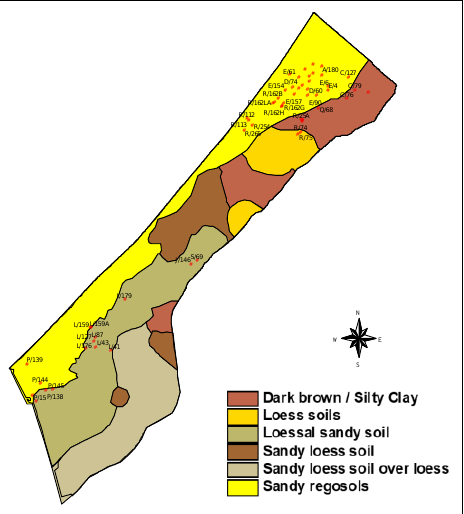
Figure 4. Study wells’ spatial distribution in Gaza Strip in terms of land use and soil